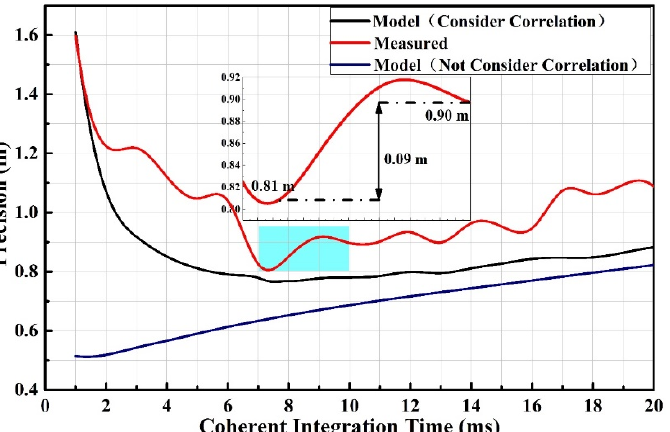
Figure 5. The variation of the precision with coherent integration time under different conditions. Red indicates the measured result. Black indicates the model result considering the correlation between the waveforms. Blue indicates the model result without considering the correlation between the waveforms.